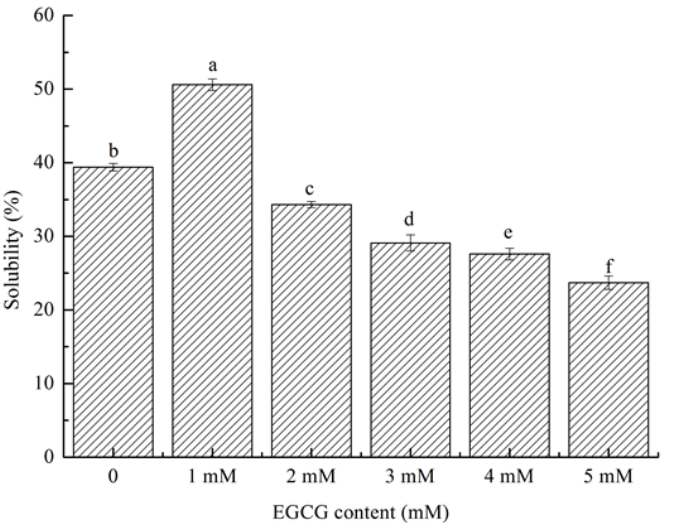
Figure 4. (a-f) Solubility of HPI and covalent HPI-EGCG complexes at EGCG concentrations of 1, 2, 3, 4, and 5 mM. 3, 4, and 5